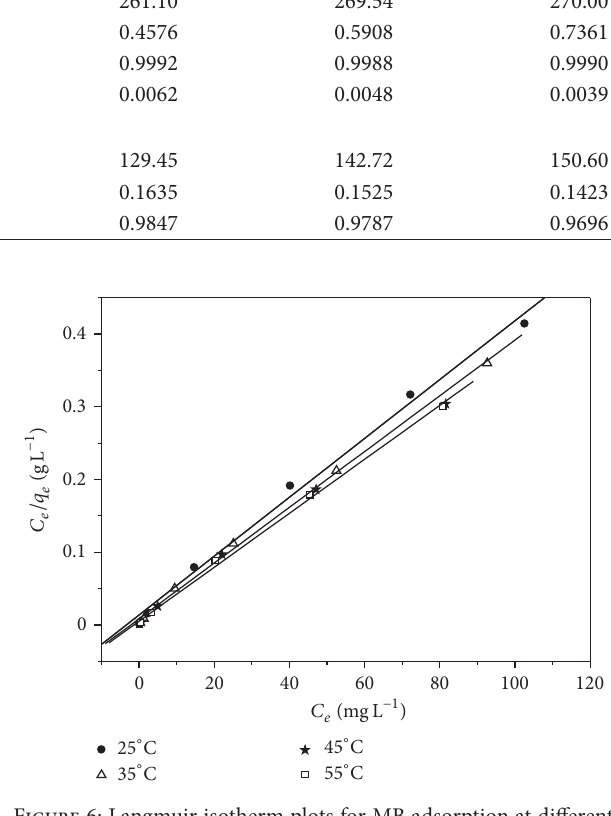
F 6: Langmuir isotherm plots for MB adsorption at different temperatures.